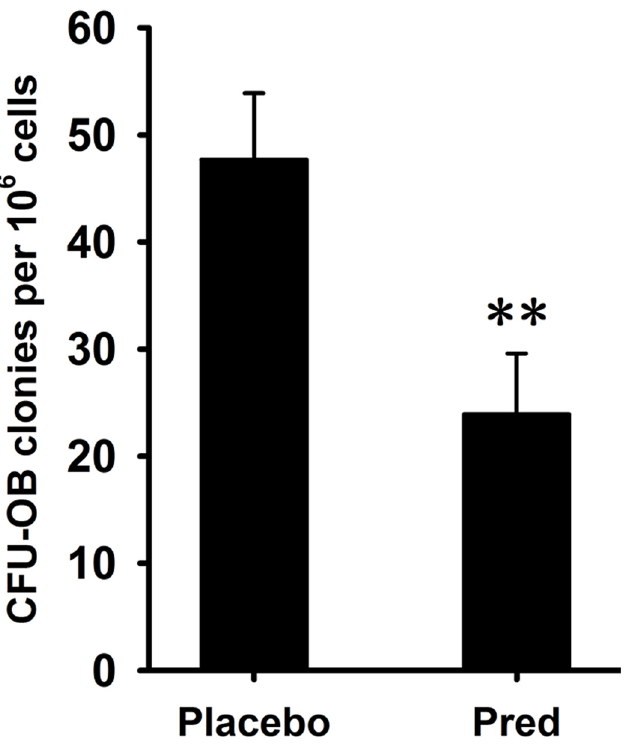
Fig 1. Quantification of CFU-OB. A glucocorticoid-induced osteoporosis (GIO) mouse model was established by subcutaneously implanting placebo- or prednisolone-releasing pellets into mice for 4 weeks. BMSCs were isolated from the vertebral body and cultured invitro . The number of CFU-OB was quantified. The results are expressed as the number of CFU-OB per 10 6 cells. The data are shown as the mean ± SD. ** : p <